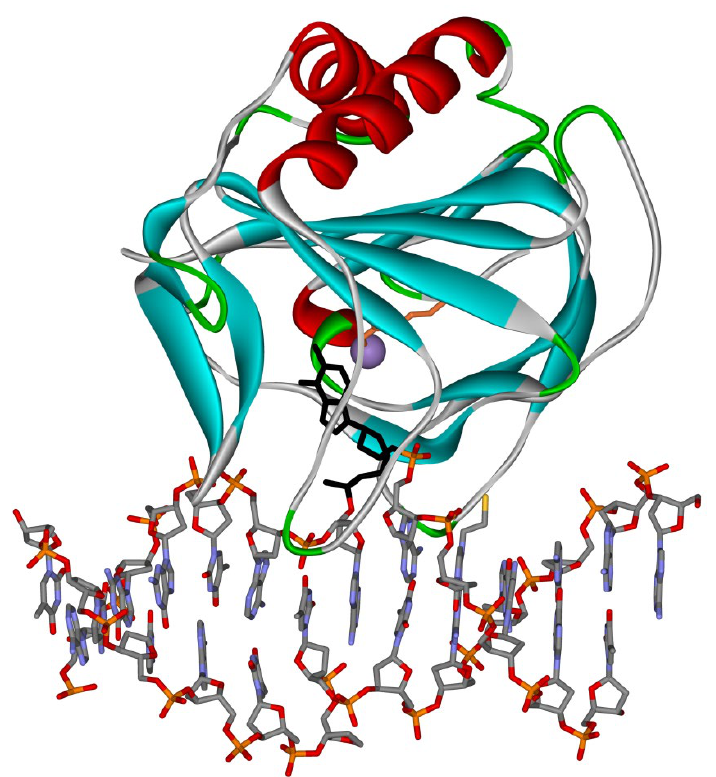
Figure 3. Three-dimensional structure of a complex of AlkB with DNA (Protein Data Bank ID: 3BIE). The figure shows damaged nucleotide m 1 A in the active site of the enzyme (black) and catalytic ion Mn(II) (purple).